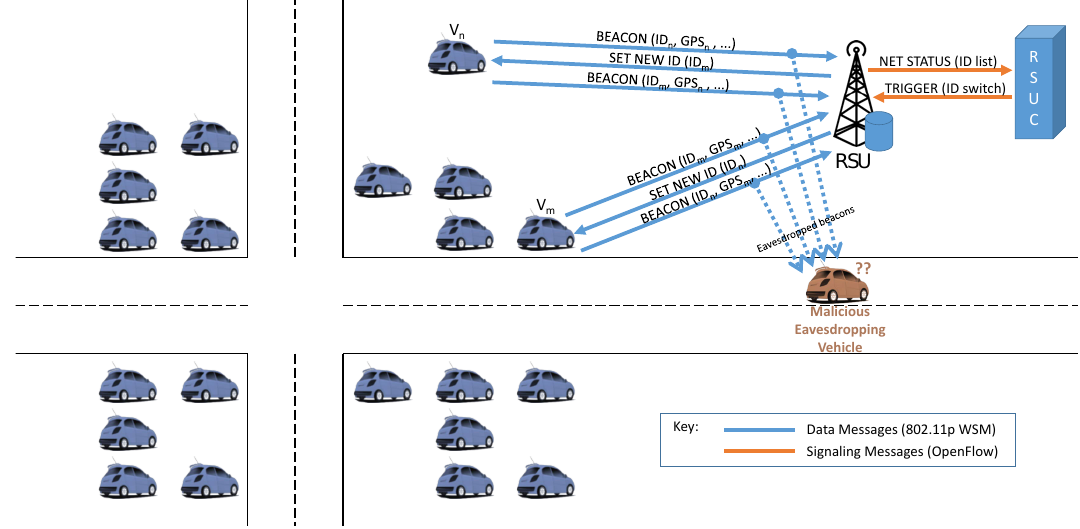
Figure 6. Eavesdropping/snooping attack in a smart parking